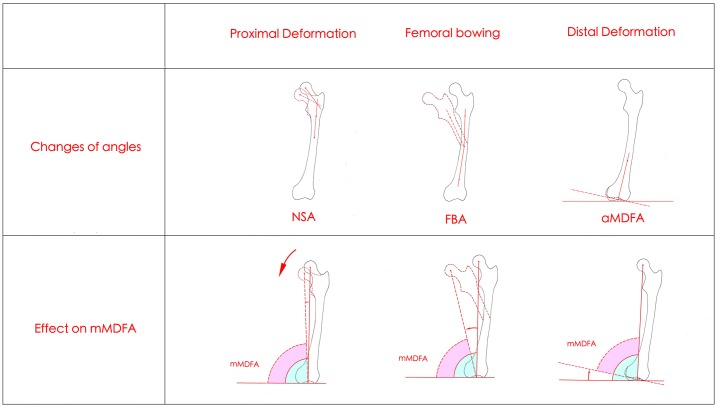
Three morphology changes effect the mMDFA.Proximal deformation (NSA changes): a decreasing NSA leads to a decreasing mMDFA; Femoral bowing (FBA changes): an increasing FBA leads to a decreasing mMDFA. Distal deformation (aMDFA changes): a decreasing aMDFA leads to a decreasing mMDFA.